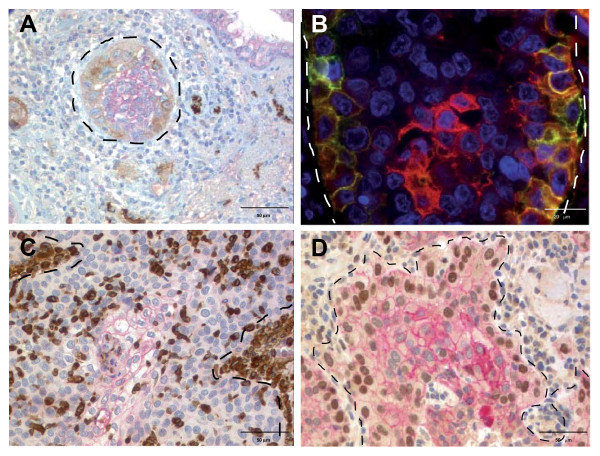
L1CAM and EMT marker expression patterns at the tumor-stroma interface. A) SCC with expression of L1CAM at the tumor-stroma interface (brown). The tumor center shows moderate E-cadherin expression (red). At the tumor-stroma interface, E-cadherin expression is decreased. Note the strong positivity of small peripheral nerves for L1CAM. B) Double IF staining for L1CAM (green) and E-cadherin (red): L1CAM is expressed at the tumor border and E-cadherin expression is strongest in the tumor center. E-cadherin expression is decreased at the tumor border (yellow). C) Membranous E-cadherin (red) is expressed in the tumor center and decreased towards the tumor-stroma interface. Two strong Vimentin positive (brown) stromal cell aggregates are marked with dotted lines (upper left and mid to lower right). Note that most of the Vimentin positive cells show nuclear morphology of the tumor cells. CD68 staining to exclude Vimentin positive macrophages was not performed. D) Decrease of membranous E-cadherin (red) and strong nuclear expression of slug (brown) at the tumor-stroma interface of a SCC. In the tumor center E-cadherin is strongly but slug is not expressed (blue nuclei). Hematoxylin and DAPI counterstain were used, respectively. Tumor-stroma interfaces are marked by dotted lines.